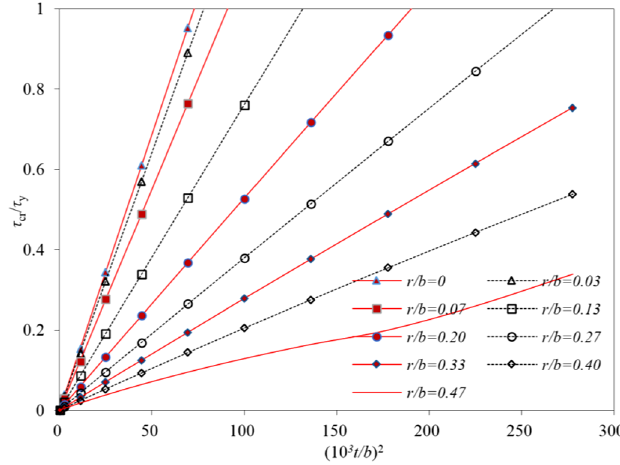
Fig. 13. The linear relation curves of square plates with square